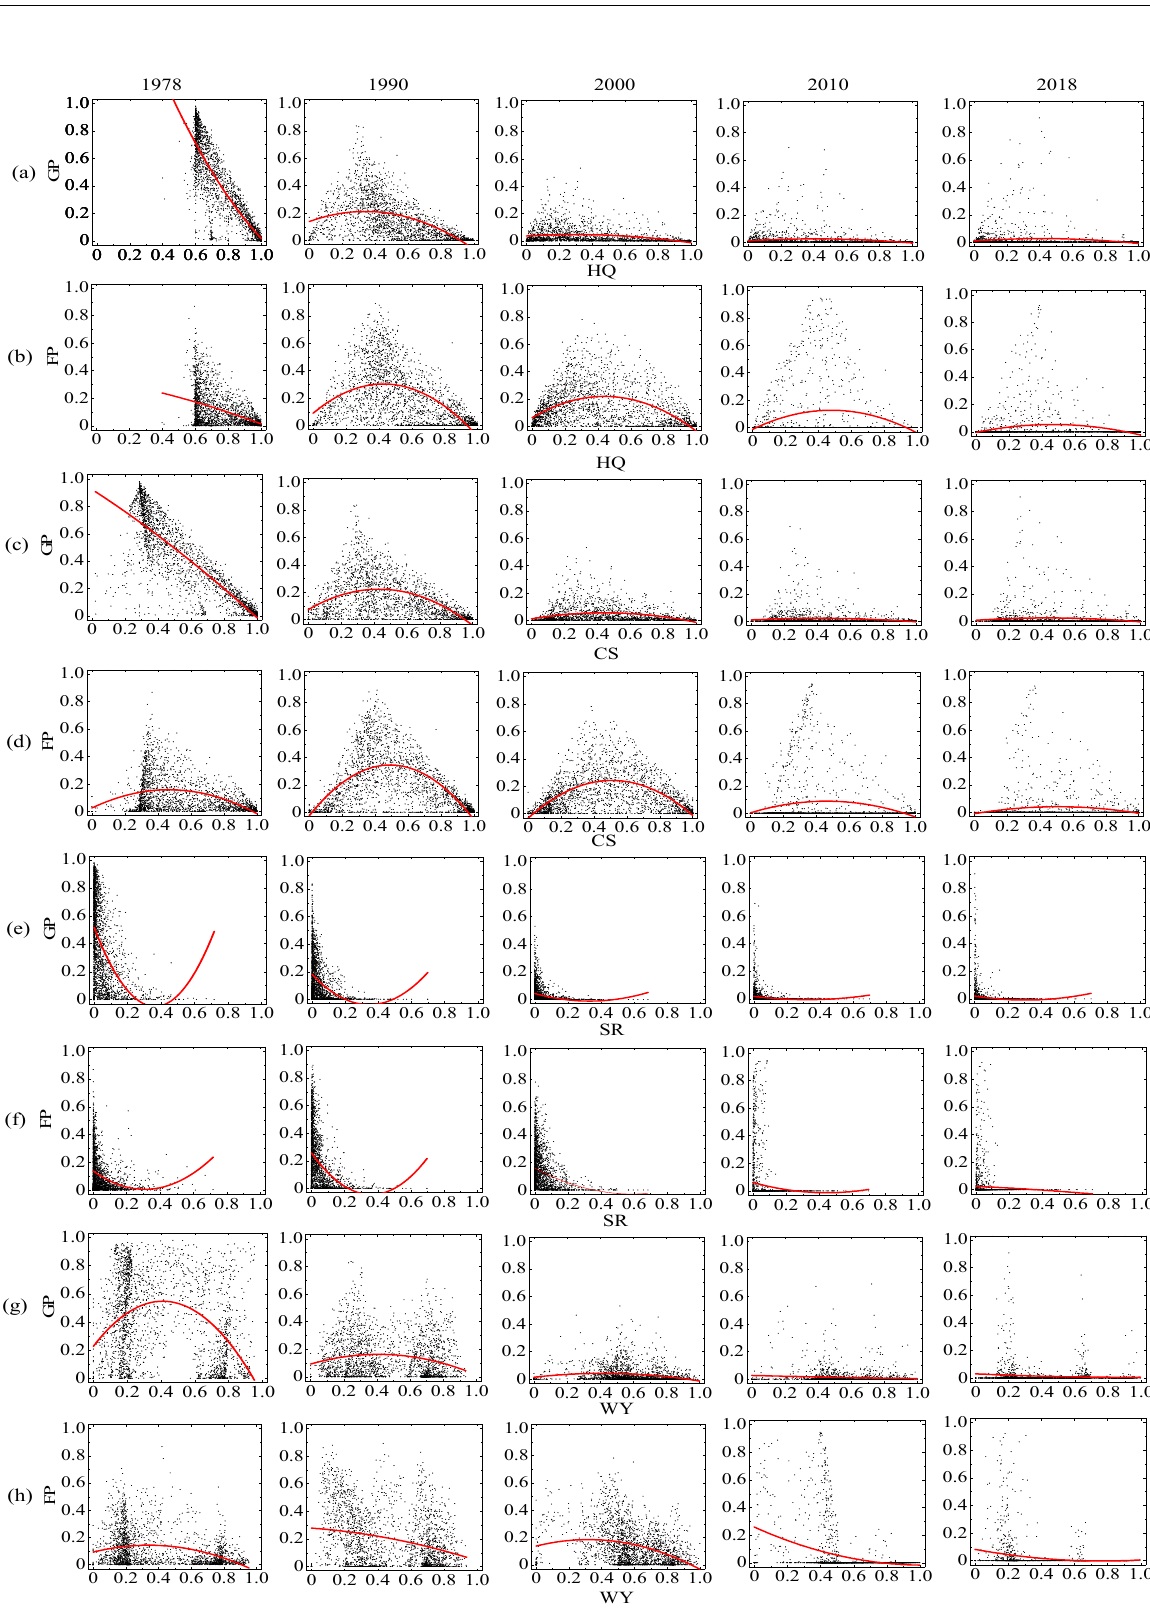
Figure 5. The trade-off evolution among ESs during 1978–2018. Ecosystem service pair for ( a ) HQ–GP; ( b ) HQ–FP; ( c ) CS–GP; ( d ) CS–FP; ( e ) SR–GP; ( f ) SR–FP; ( g ) WY–GP; ( h ) WY–GP. Plots in the same row represent different years. Supporting services and regulating services (including HQ and CS, HQ and SR, HQ and WY), three types of regulating services (including CS and SR, CS and WY, SR and